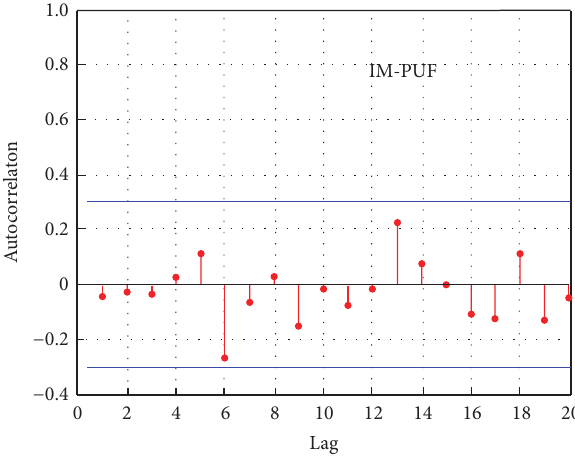
Figure 9: Frequency curve of PUF circuit.